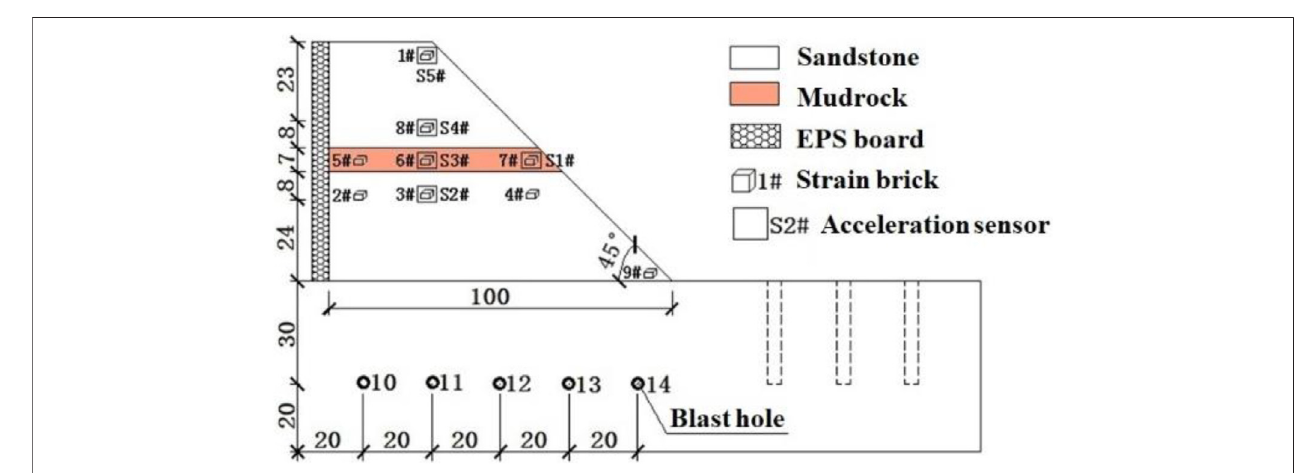
FIGURE 2 | Sectional view of the test